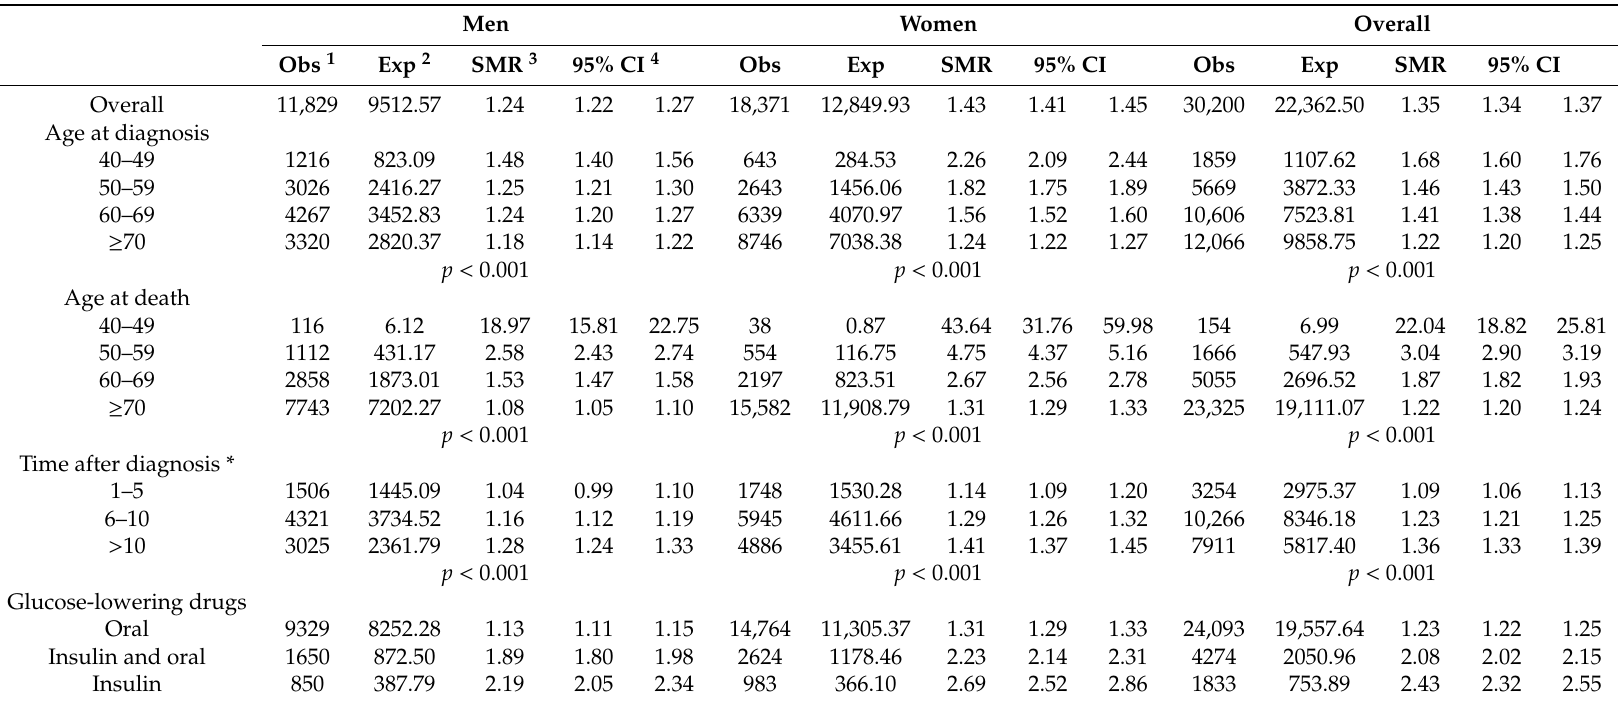
Table 2. Standardized mortality ratios for all causes of death for men, women, and the overall cohort according to sex, age at diagnosis, age at death, time after diagnosis, and